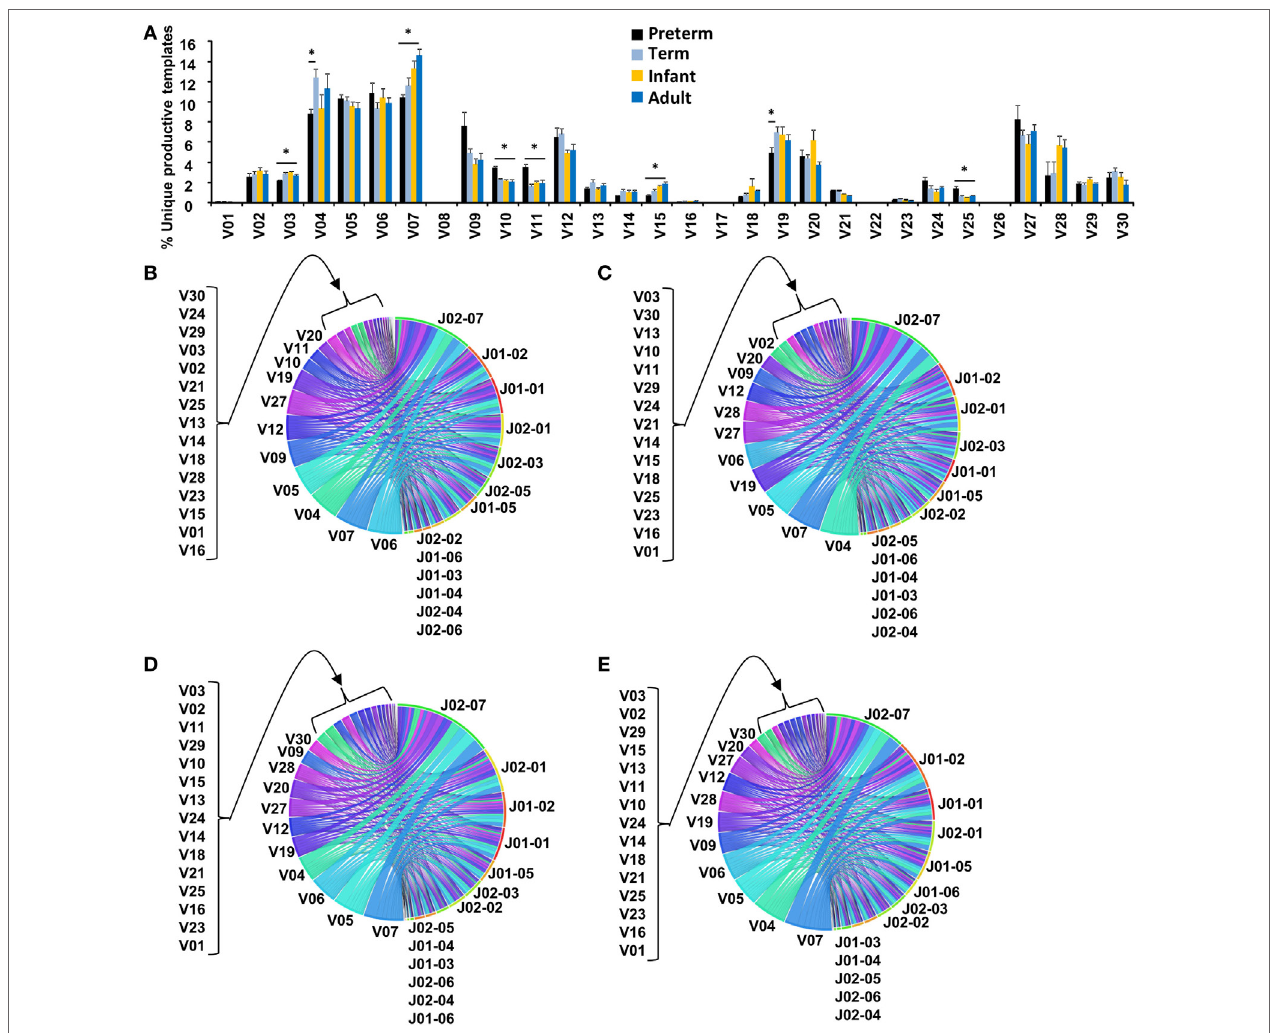
FigUre 1 | VJ joining in the human repertoire is mature by the end of the second trimester of pregnancy. (a) The percentage of total V β gene family usage (mean ± SEM) of all unique productive templates shown. Unpaired Student’s t -test was performed to compare an age group to one other age group. * represents p < 0.05. Representative Circos plots of frequencies of V β and J β usage and combinations of unique productive templates shown for (B) preterm neonate, (c) term neonate, (D) young child, and (e) adult. The width of the band is proportional to the